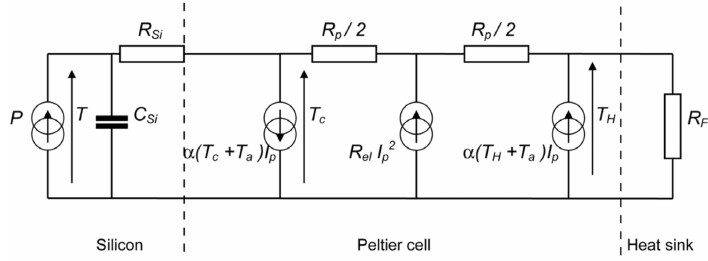
Figure 4. Equivalent thermal network for the structure of Figure